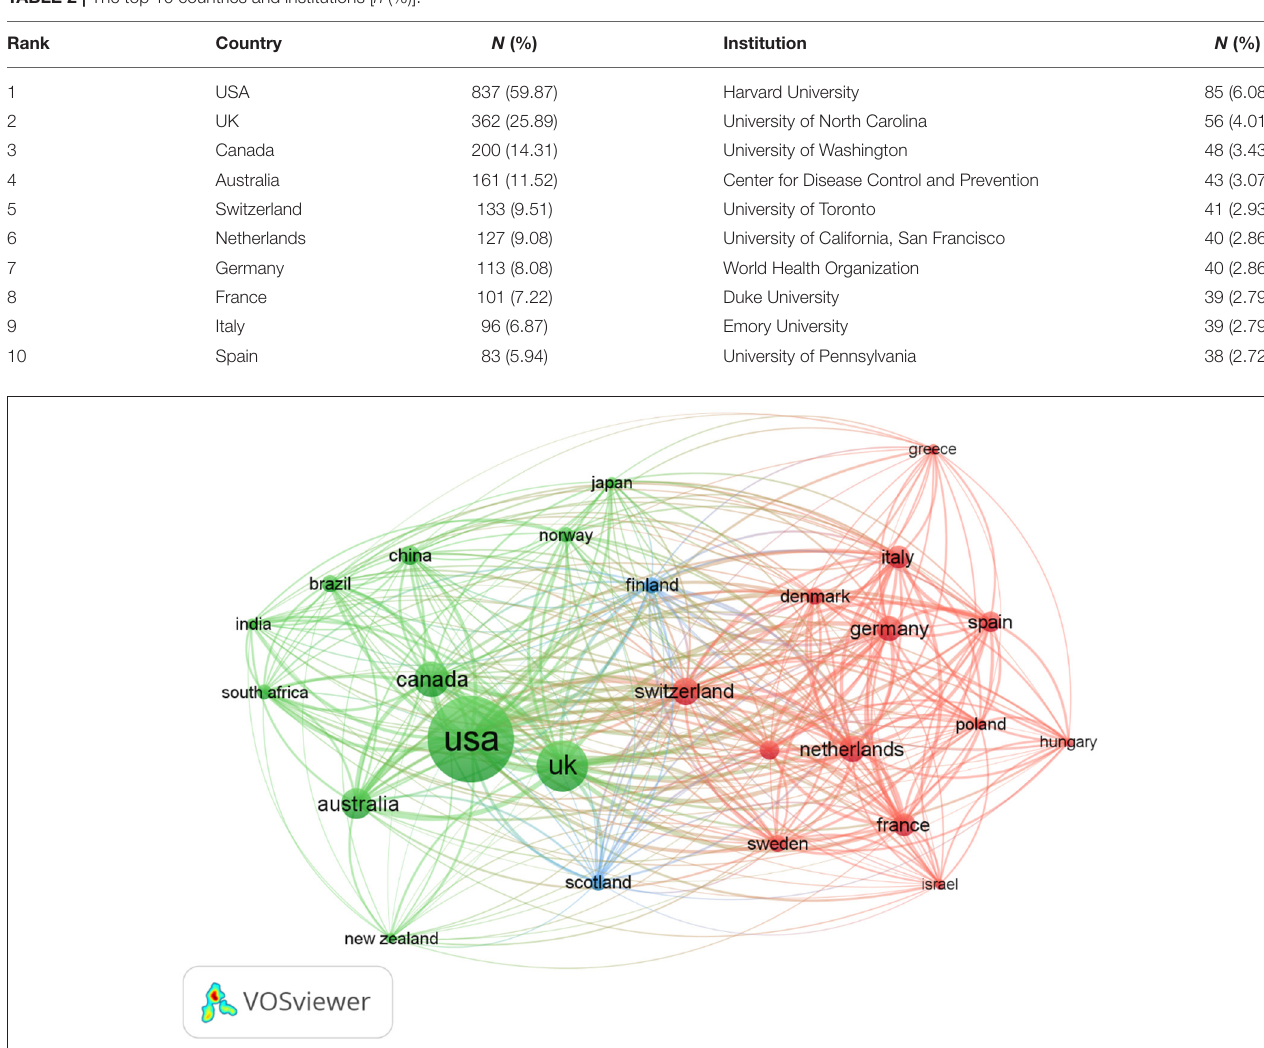
TABLE 2 | The top 10 countries and institutions [ n (%)].